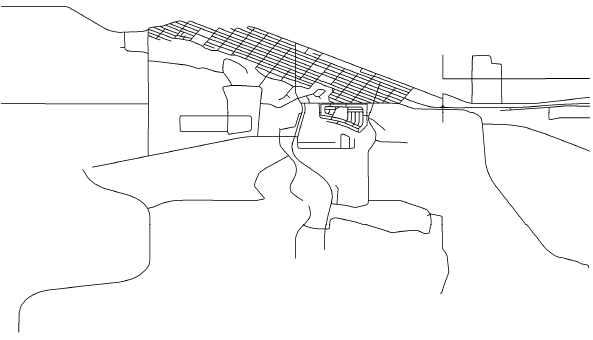
Figure 7. The main self ‐ connected part of the Estevan road network returned by the function nt.connect.